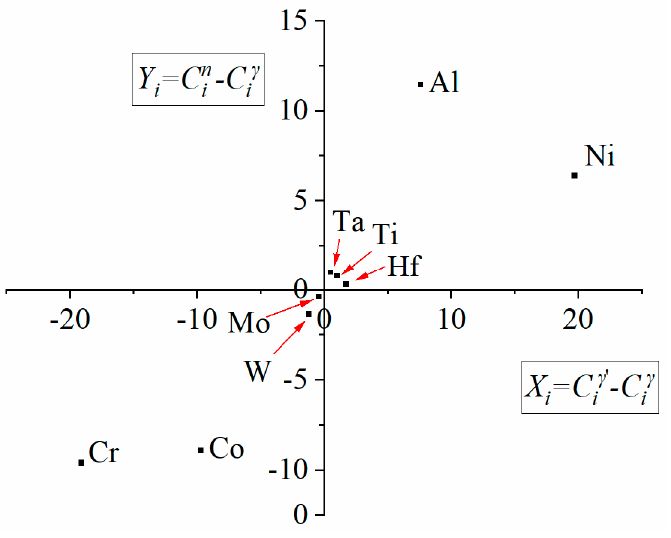
γ (cid:48) − C γ − C γ Figure 14. Plot C n vs. C calculated based on the composition of the bulk superalloy, i i i i Figure 14. Plot 𝐶 (cid:3036)(cid:3041) − 𝐶 (cid:3036)(cid:3082) vs 𝐶 (cid:3036)(cid:3082)(cid:4593) − 𝐶 (cid:3036)(cid:3082) calculated based on the composition of the bulk superalloy, secondary γ (cid:48) and the matrix. secondary γ ' and the matrix.